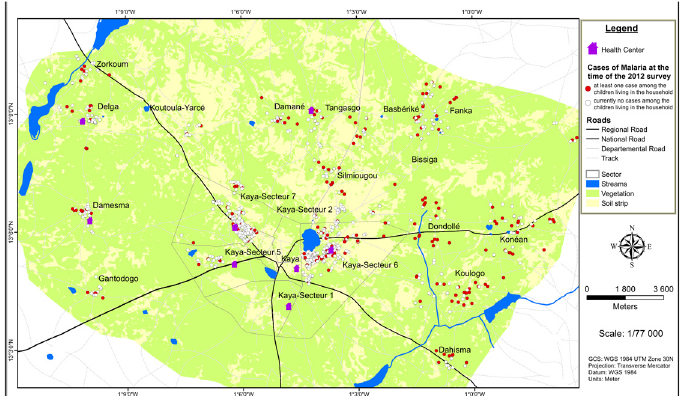
Fig 1. Distribution of the households surveyed. A total of 2,004 households were surveyed in 17 rural and urban sectors within a radius of 20 kilometres in the Kaya Health District, North-Central Burkina Faso. The area includes streams and stretches of stagnant water, and cases of malaria in children under five are found throughout the area.